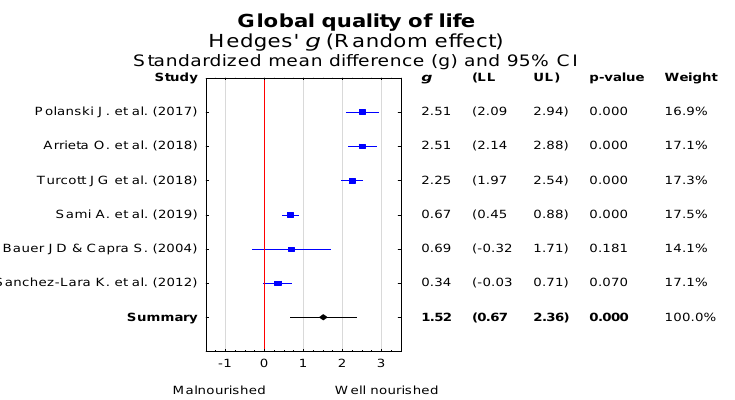
Figure 2. Global QoL in lung cancer patients with a different nutritional status (expressed as corrected standardized mean difference—Hedges’ g). LL—lower limit of the confidence interval, UL—upper limit of the confidence interval for the effect measure ( g ).